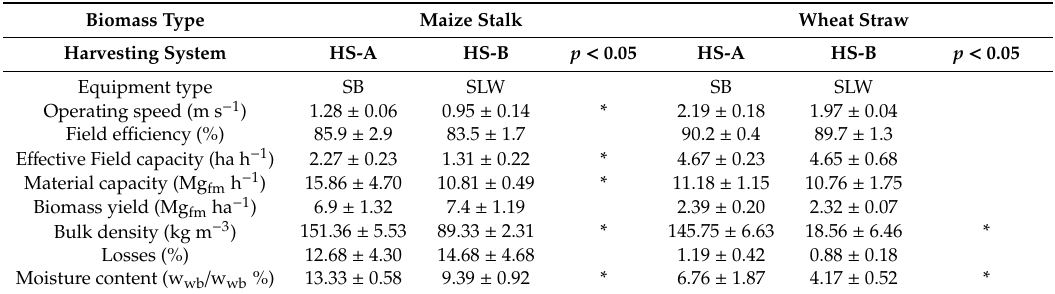
Table 2. Machine performance and quality of the work of the harvesting